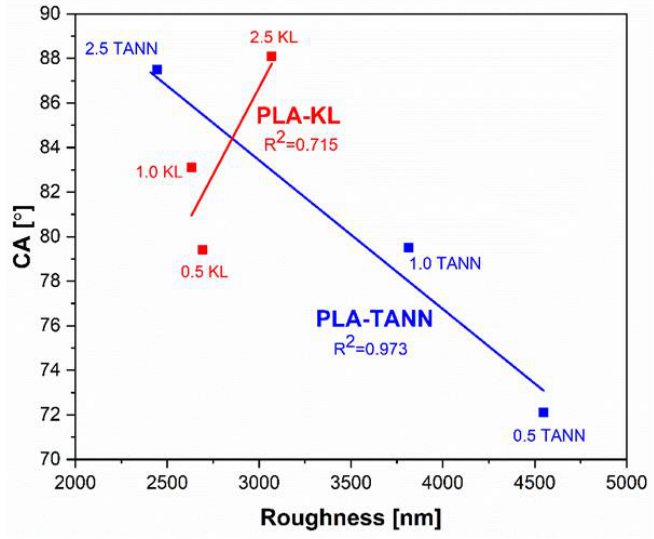
are stronger or more pronounced with decreasing loading of polyphenolic filler and lead to Figure 3. An average roughness value of neat PLA, PLA-TANN, and PLA-KL composites. a higher availability in the inner region of PLA-KL and PLA-TANN composites, causing the changes in the surface region. In general, the trend of change in the water contact angle of PLA-KL and PLA-TANN composites agrees well with that of surface roughness, indicating the distribution of KL and TANN in PLA composites and varies in different deep layers of PLA-KL and PLA-TANN composites (Figure 4). From the correlation plot between CA and roughness (Figure 4), the correlation coefficient for PLA-TANN is high (0.973), indicating higher linear strength, while the lowest correlation coefficient is calculated for PLA-KL (0.715), which is still considered strong.